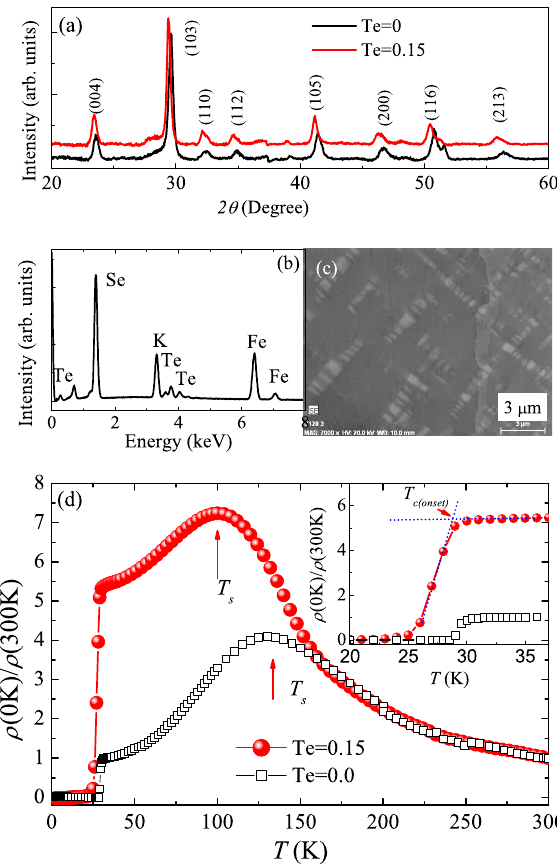
FIG. 1. A nominal 7.5% Te substitution of Se in K x Fe 2 − y Se 2 induces a decrease of the superconducting transition temperature T c and of the semiconductor-metal transition temperature (a) The powder x-ray diffraction patterns for Te-doped and pure K x Fe 2 − y Se 2 crystals. The shift of the diffraction peaks toward lower angles shows the expanded lattice in Te-doped crystals. (b) The energy-dispersive x-ray spectroscopy of a typical Fe 1 Se 1 Te 0 single crystal, which clearly shows the K 0 . 70 . 46 . 85 . 15 Te peak. (c) The SEM image of a typical single crystal showing stripe phases. (d) Temperature dependence of the resistivity for pure and Te-doped K x Fe 2 − y Se 2 . The inset shows the magnified part around the superconducting transition temperature. T c ð decreases from 30 to 29.5 K, and T s decreases from 130 to 100